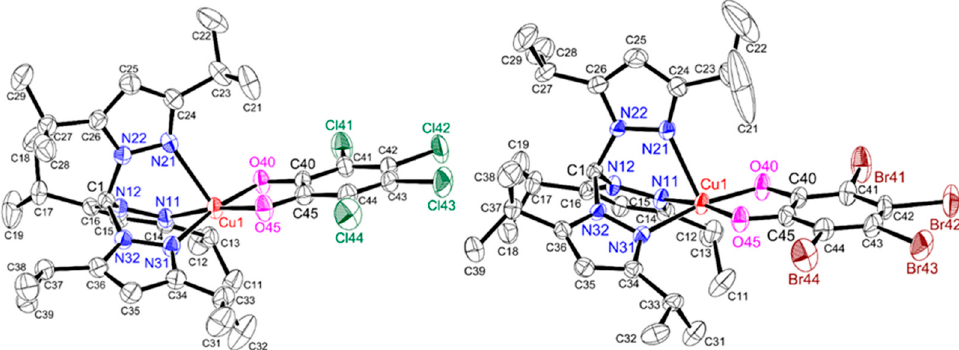
Figure 1. Crystal structures of [Cu(catCl 4 )(L1 ′ )] ( left ) and [Cu(catBr 4 )(L1 ′ )] ( right ) showing 50% displacement ellipsoids and the atom labeling scheme. Hydrogen atoms and solvents were omitted for reasons of clarity. Relevant bond lengths (Å) and angles (°): Cu1–N11, 2.036(2); Cu1–N21, 2.313(2);